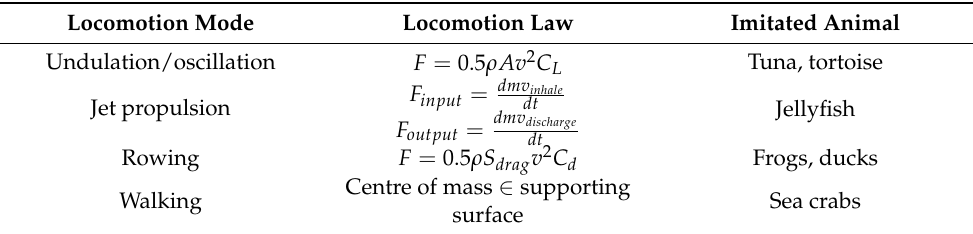
Table 1. Photographs, fundamental laws of various types of locomotion, and corresponding ani- mals